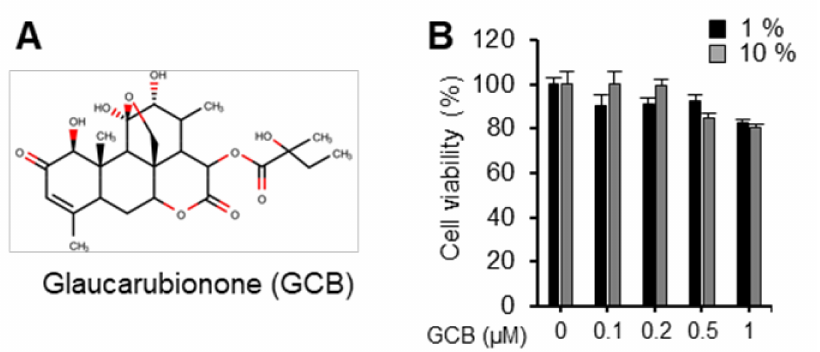
Figure 1. GCB was one of the top candidates without significant cytotoxicity. ( A ) Chemical structure of GCB. ( B ) Huh7 cells were treated with GCB at the indicated concentration in the cell culture medium containing 1% or 10% FBS for 24 h. The cell viability was measured using the EZ-CYTOX solution. The relative cell viability is shown using bar graphs in comparison with the untreated control (100%). Data are representative of three experiments and are expressed as the mean ±